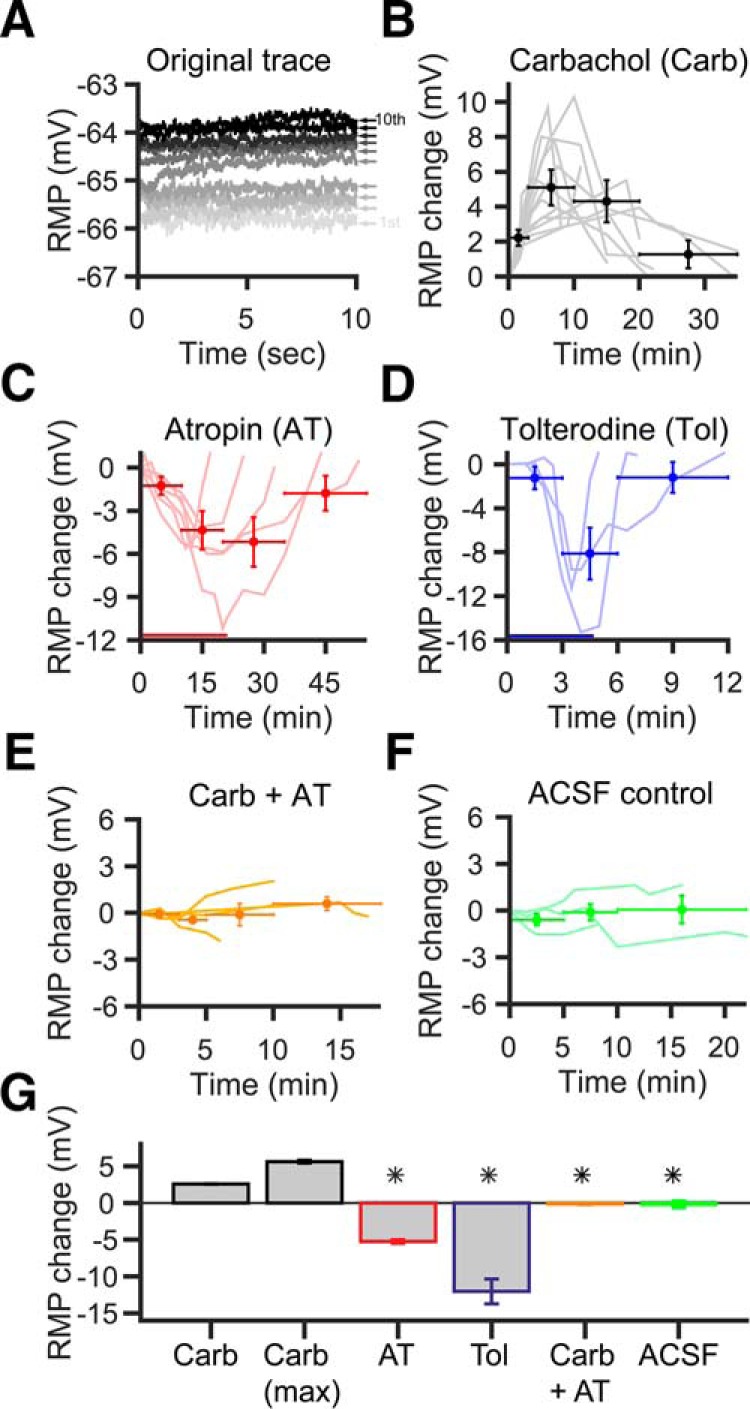
Acetylcholine sets the SBC RMP through muscarinic receptors. A, Representative example trace of SBC depolarization during puff application protocol (see Materials and Methods). The darker the trace, the later the recording took place. Small numbers and the arrow right of the traces indicate puff number. Note the persistent elevation of the RMP, which tends to increase with repeated puff applications. B, Course of RMP changes after 10 carbachol puff applications (0.1 Hz). Gray lines show the RMP courses of single cells (n = 13). Circle markers show time-binned RMP averages of all cells: The horizontal error bars indicate the used time interval to calculate the mean, and the vertical error bars denote SD (middle of the crosshair). C, Washin of 2 µm AT (red bar) strongly hyperpolarized the cells. This effect was reversible, and RMP returned to baseline values after washout of AT (n = 6, light red lines). Circle markers and error bars show interval and SD of time-binned RMP averages. D, Washin of the specific mAChR blocker Tol (100 nm, blue bar) showed a similar effect as AT washin (light blue lines, n = 3); crosshairs show intervals and SD of time-binned RMP averages. Note that differences in the time course of atropine vs tolterodine effects are due to the different perfusion systems used. E, Carbachol application under atropine block. No depolarization occurred when mAChRs were blocked. Light orange lines, single cells (n = 5); circle markers, time-binned averages ± SD of all cells. F, Control experiment with application of the vehicle only (ACSF). No depolarization was visible after application. Light green lines, single cells (n = 3); circle markers, time-binned average of all cells ± SD. G, Population data for all cells. Bars show the mean of the maximum RMP change. *Significant difference from carbachol condition (p < 0.01, Kruskal–Wallis test with Bonferroni post hoc test).